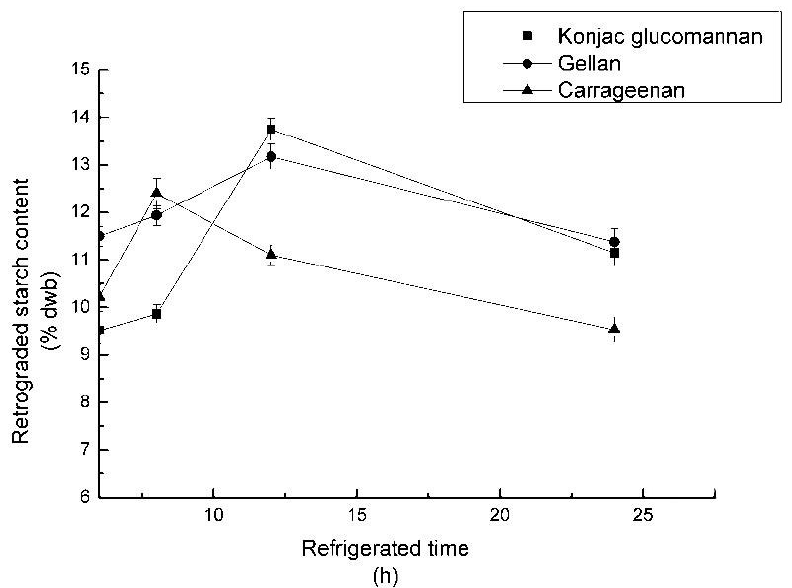
Figure 5. Effect of refrigerated time on RS